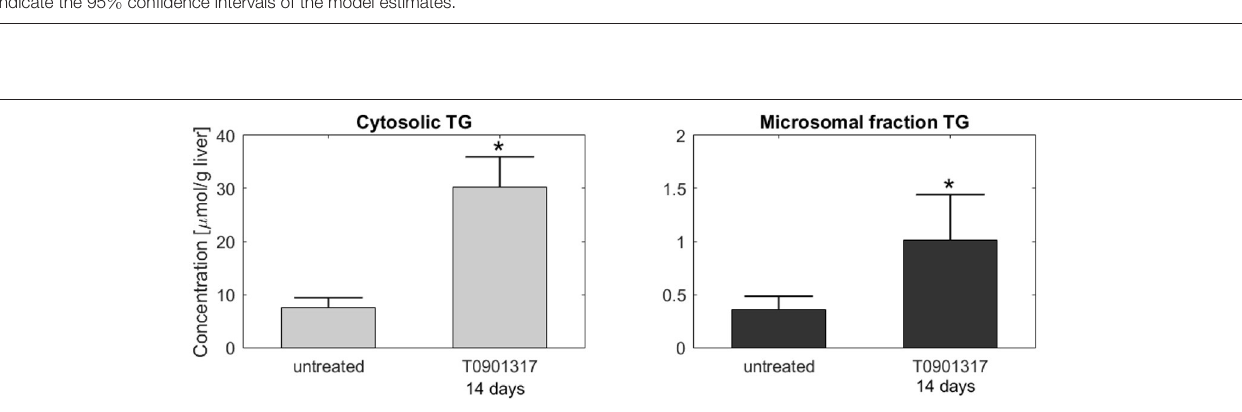
Frontiers in Bioengineering and Biotechnology |